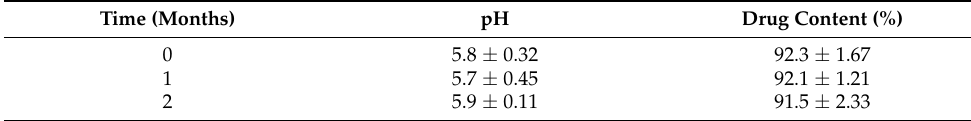
Figure 8. Texture analysis graph of QCT@NG representing the consistency, firmness, cohesiveness and work of cohesion. Table 1. Stability data of the optimized QCT@NG (mean ± S.D.).